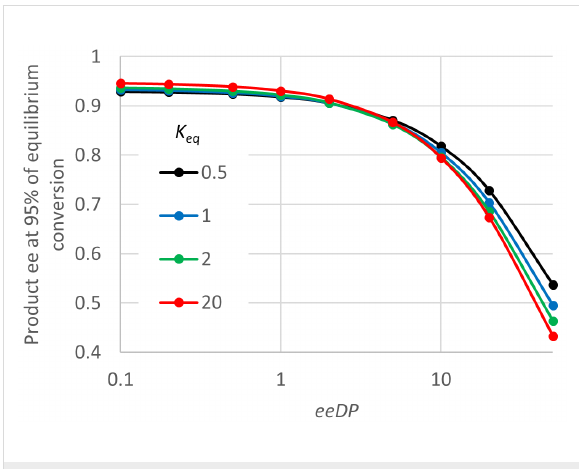
Figure 5: Effect of the key ee decline parameter ( eeDP ) of the en- zyme on the product ee for “ping-pong, second” kinetics. S 0 = 0.2 M, D = 0.4 M, E = 39, K MS = 0.01 M, k 2 = 1000 s − 1 , SCRf / b = 1,